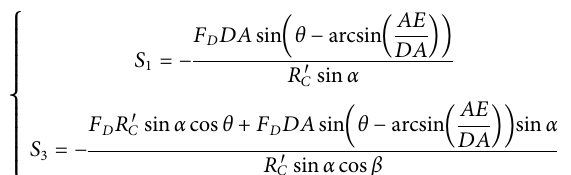
Graph of the dependence of the force acting on elastic elements on the size of the